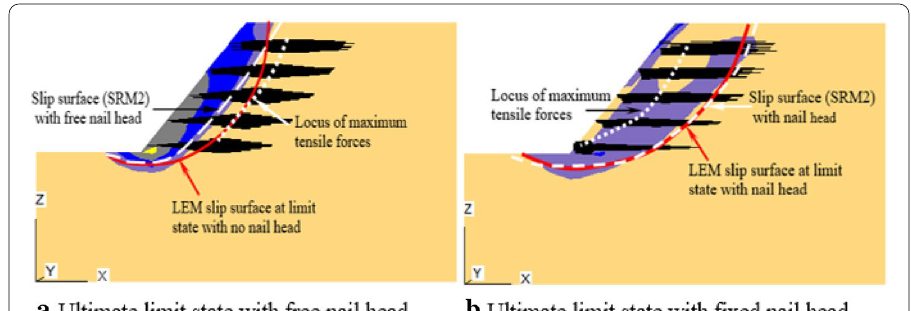
Fig. 7 Ultimate limit response of the embankment slope under nail head